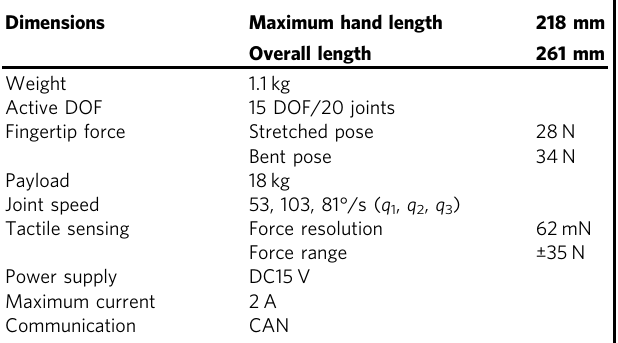
Table 1 Technical speci fi cations of the developed ILDA hand.